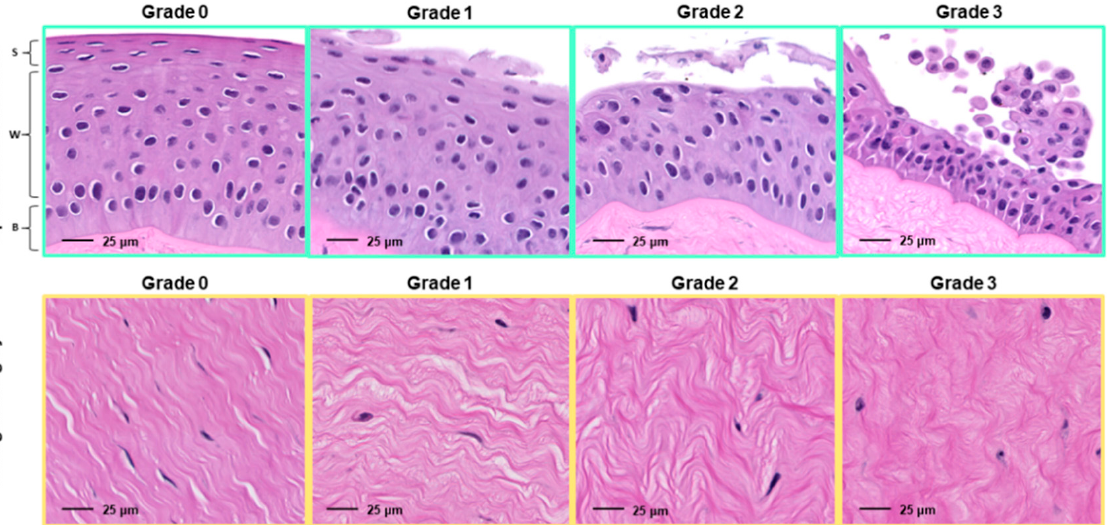
Table 1. Half-maximal inhibitory concentrations for nucleoside analogue antiviral agents against BoHV-1, determined using curve fit